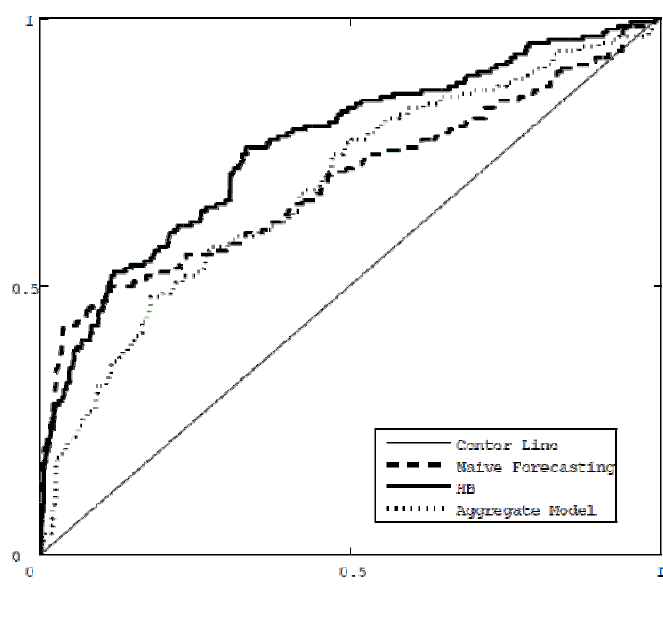
Figure 3. Cumulative gain chart of ASIAN KUNG-FU